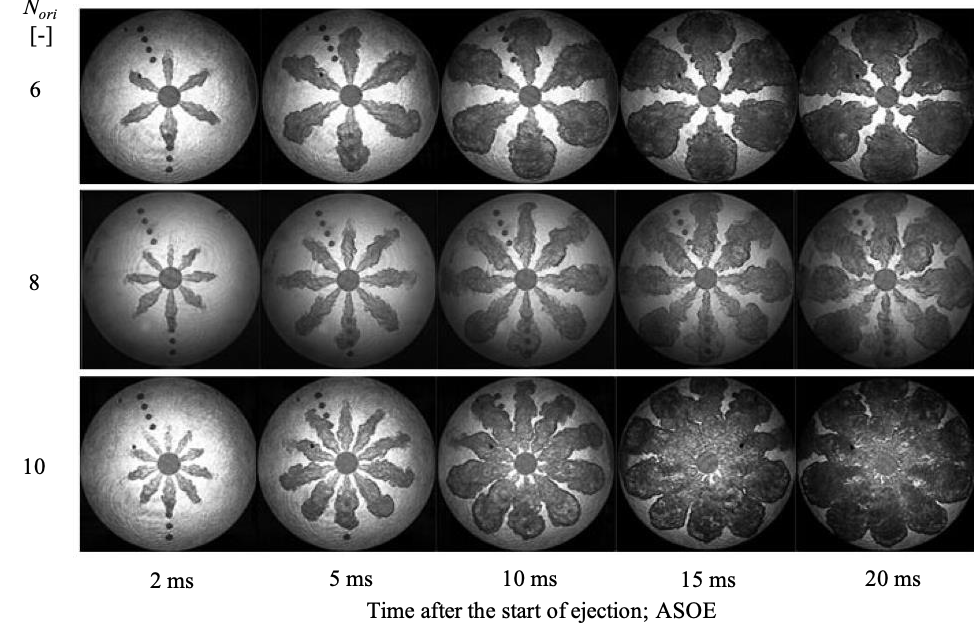
Fig. 12. Shadowgraph images of the different number of orifices (N ori = 6, 8,10) under “combustible”